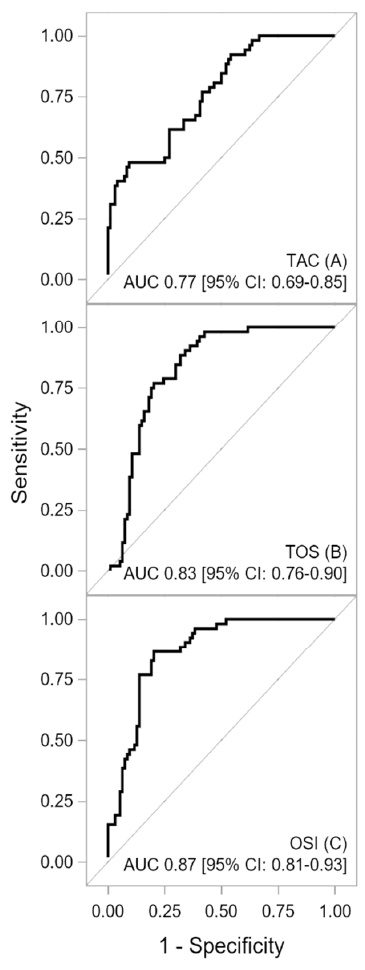
Figure 1. Receiver operating characteristic curves for TAC ( A ), TOS ( B ), and OSI ( C ) concentrations. Description: The area under the receiver operating characteristic curve indicated a good discriminatory power of TAC and TOS levels for HCM detection. The combined assessment of the oxidative-antioxidative balance by OSI showed excellent discriminatory power for HCM detection. Abbreviations: AUC—area under curve; CI—confidence interval; OSI—oxidative stress index; TAC—total antioxidant capacity, TOS—total oxidant status.